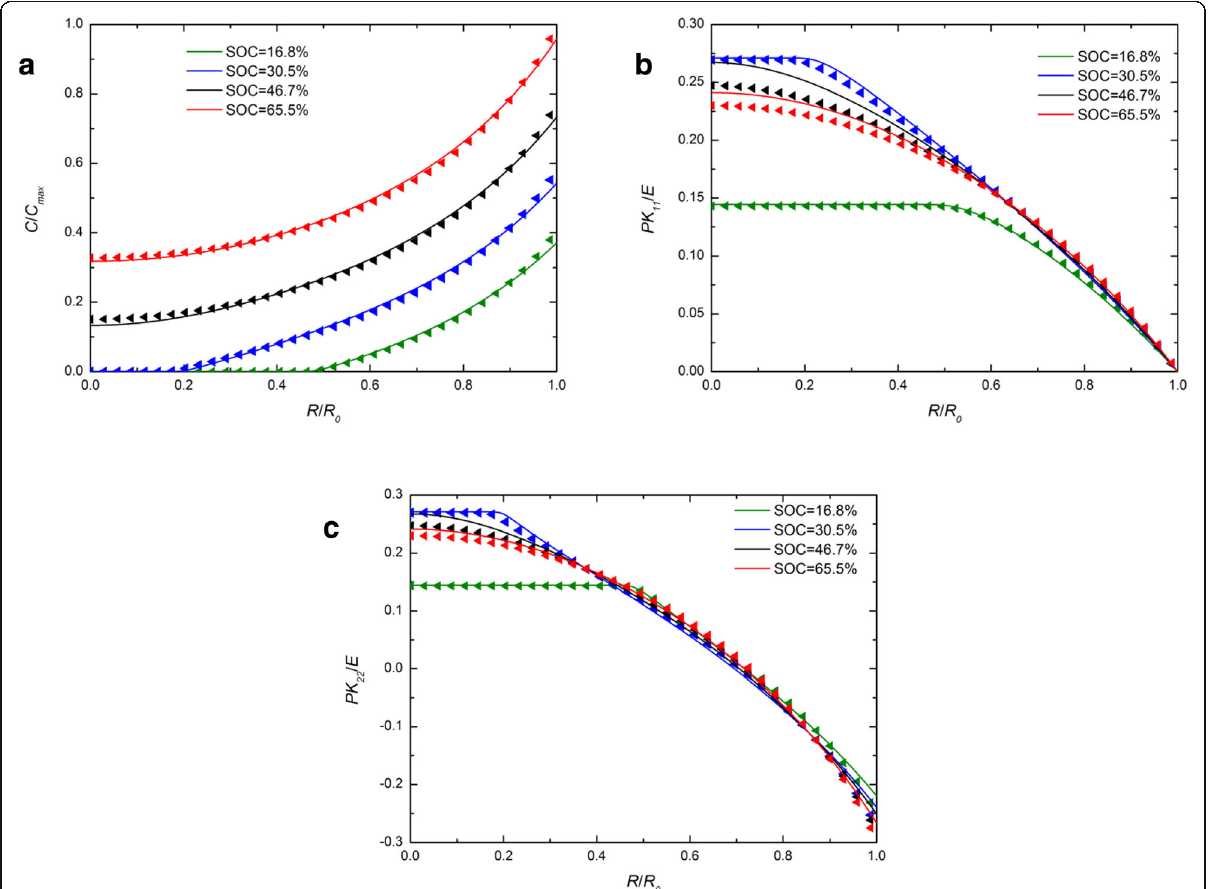
Fig. 1 Spatial distribution of ( a ) the concentration of lithium, ( b ) radial stress, and ( c ) hoop stress in a spherical Si electrode at different SOCs under galvanostatic operation (solid lines represent the results with the traditional expression of chemical potential; triangles lines represent the results with the developed expression of chemical potential)